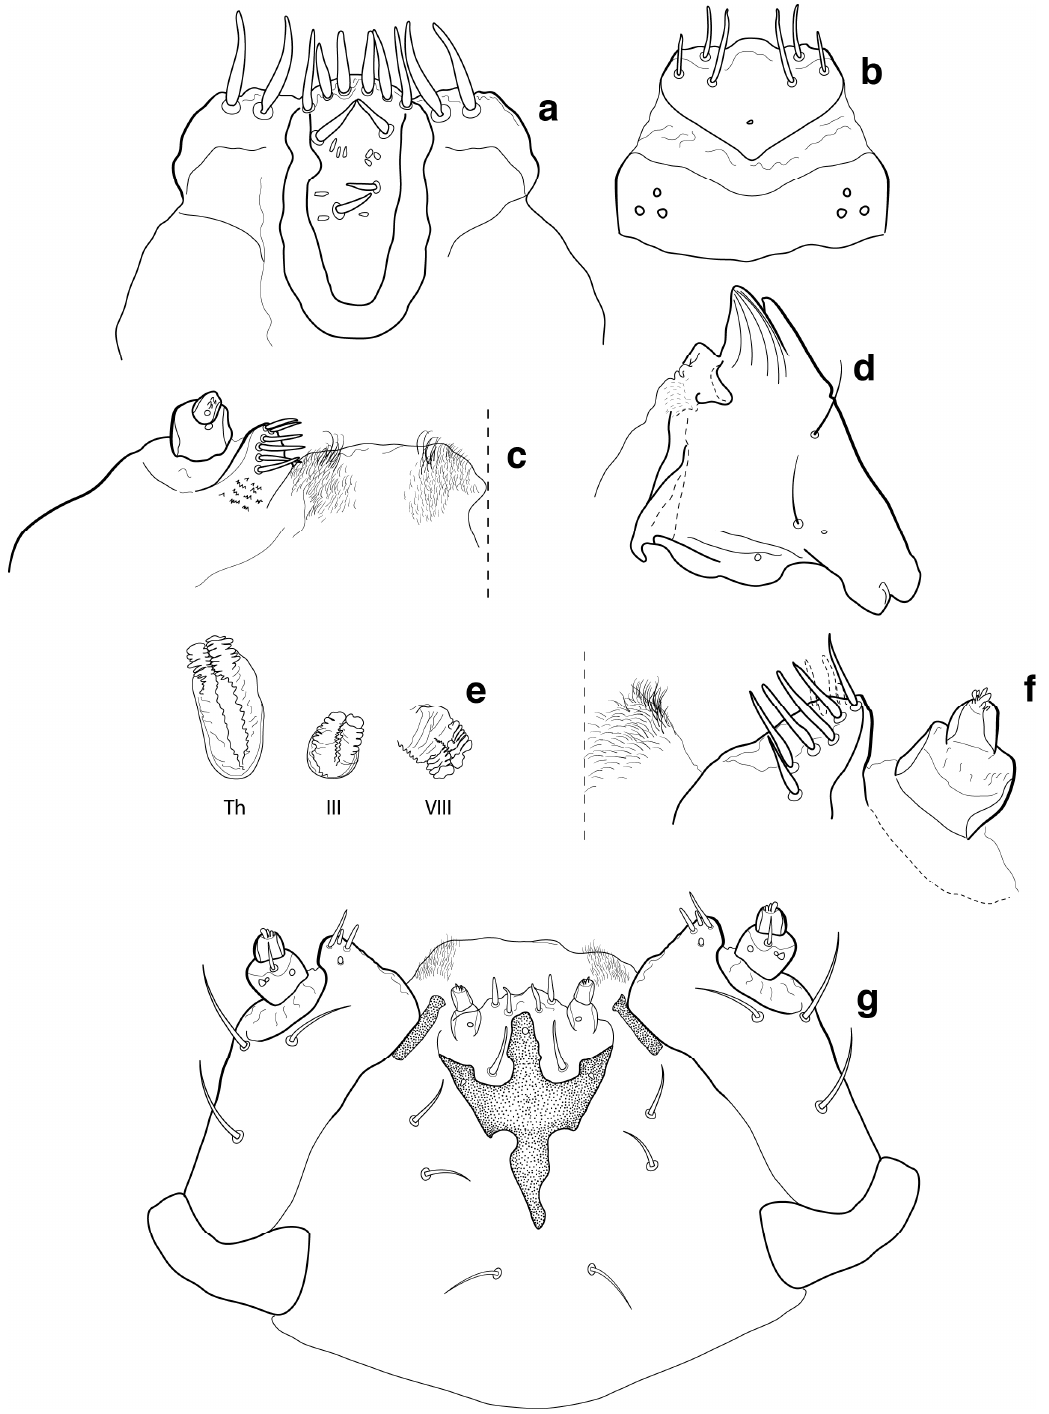
Figure 90. Tryphetus incarnatus mouthparts: ( a ) epipharynx; ( b ) labrum and clypeus; ( c ) detail of hypopharynx, mala, and maxillary palp, dorsal view; ( d ) mandible; ( e ) spiracles; ( f ) detail, mala, hypopharynx, maxillary palp, dorsal view; and ( g ) labio-maxillary complex, ventral view. Th: thorax; III: 3 rd abdominal segment; VIII: 8 th abdominal segment.